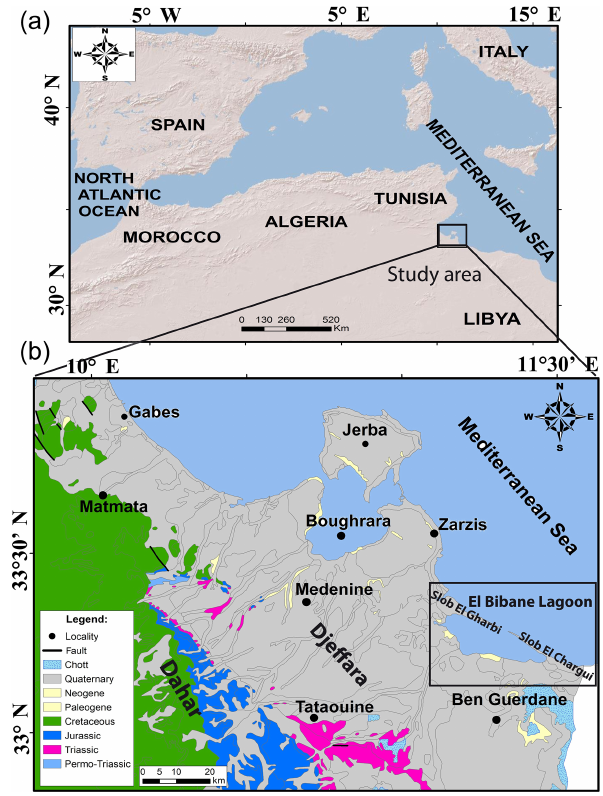
Figure 1. Location of the study area of El Bibane Lagoon, south- eastern Tunisia (a) , and the geological map of southeastern Tunisia (modified from the geological map of Tunisia, 1:500000, after Ben Haj Ali et al., 1985; b